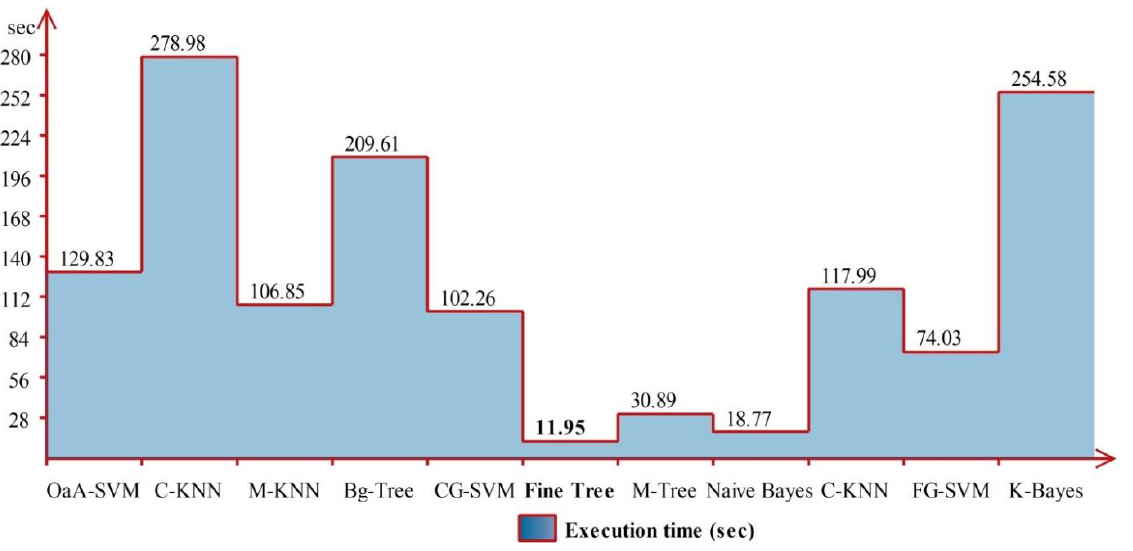
Figure 13. Execution time of proposed method on real-time dataset (normal walking and walking while carrying a bag).